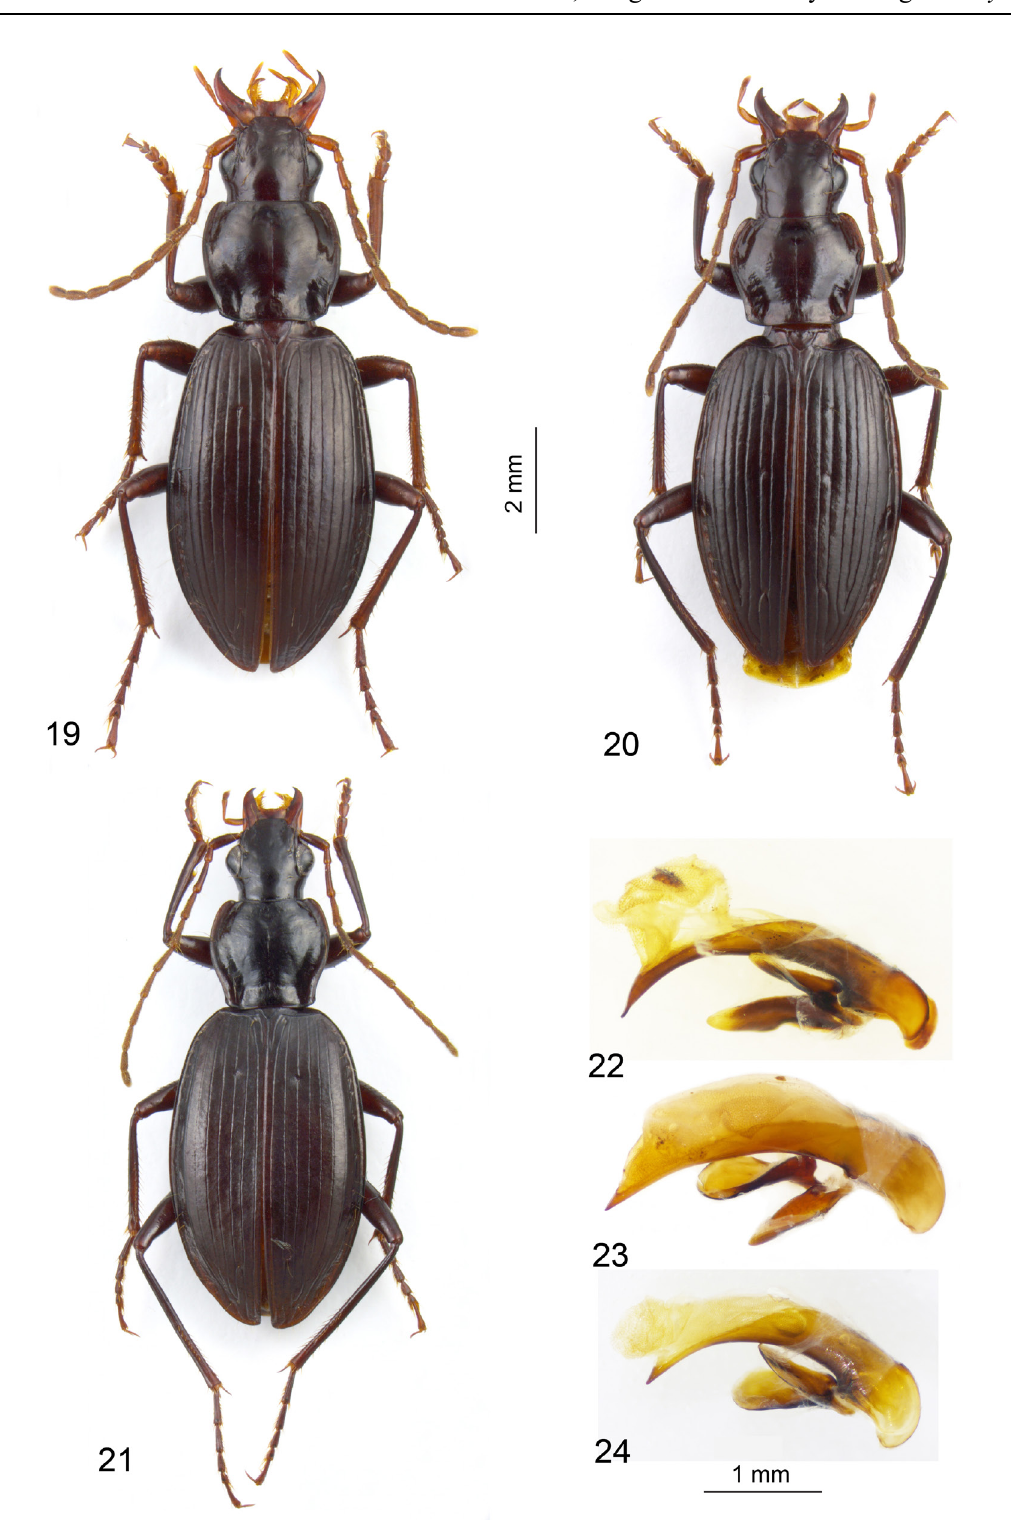
Figs 19–24. Dyscolus spp., habitus (19–21) and aedeagus, median lobe in lateral view